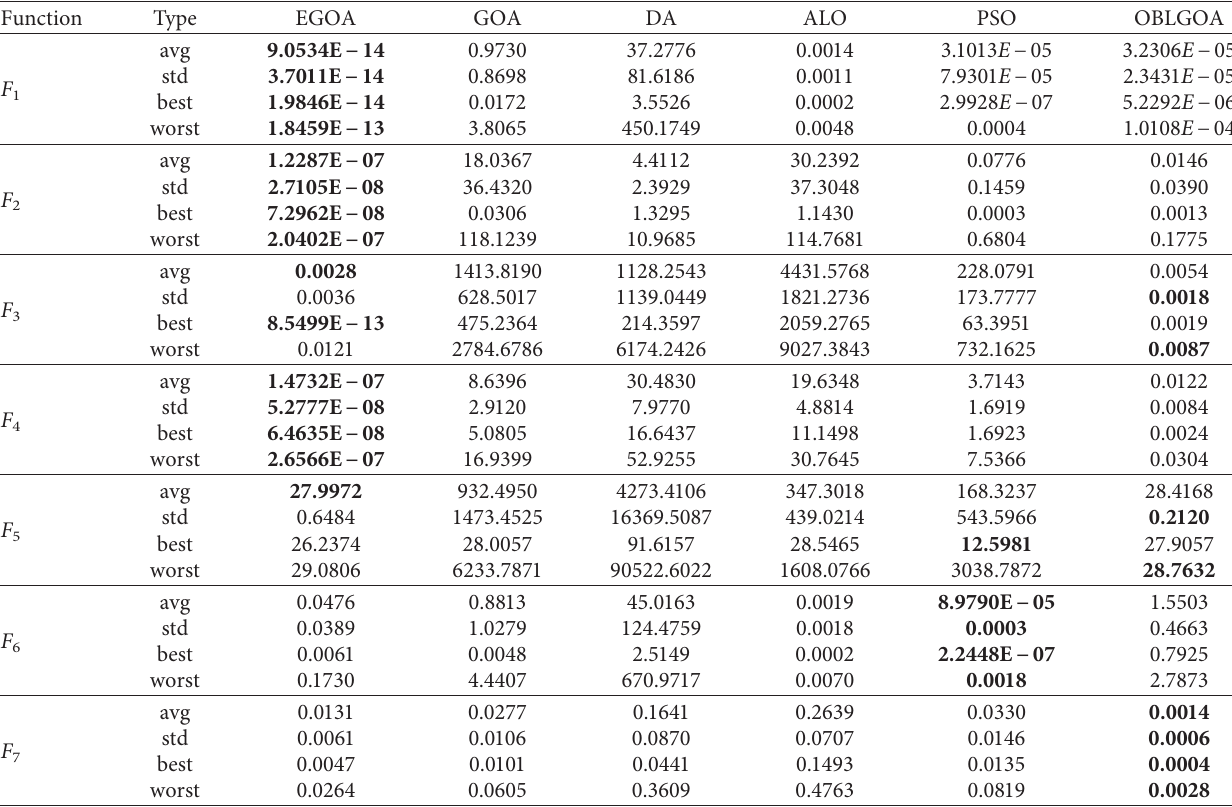
Table 3: Results for unimodal